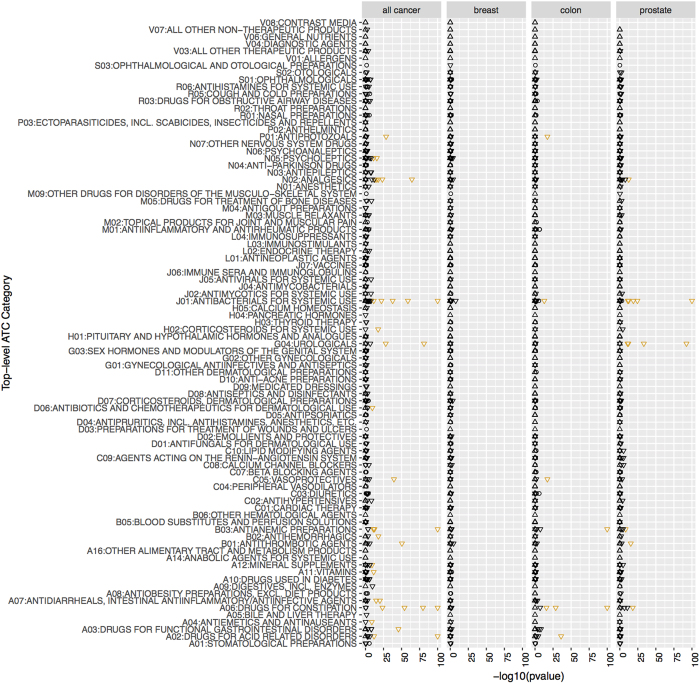
Manhattan plot (−log10(p-value)) for each drug categorized by Anatomical Therapeutic Chemical anatomical main group) in case-crossover analyses.Orange color denotes tentative signals. P-values lower than 1 × 10−100 set to 1 × 10−100 for clarity. Upward triangles indicate OR >1 and downward triangles OR <1.